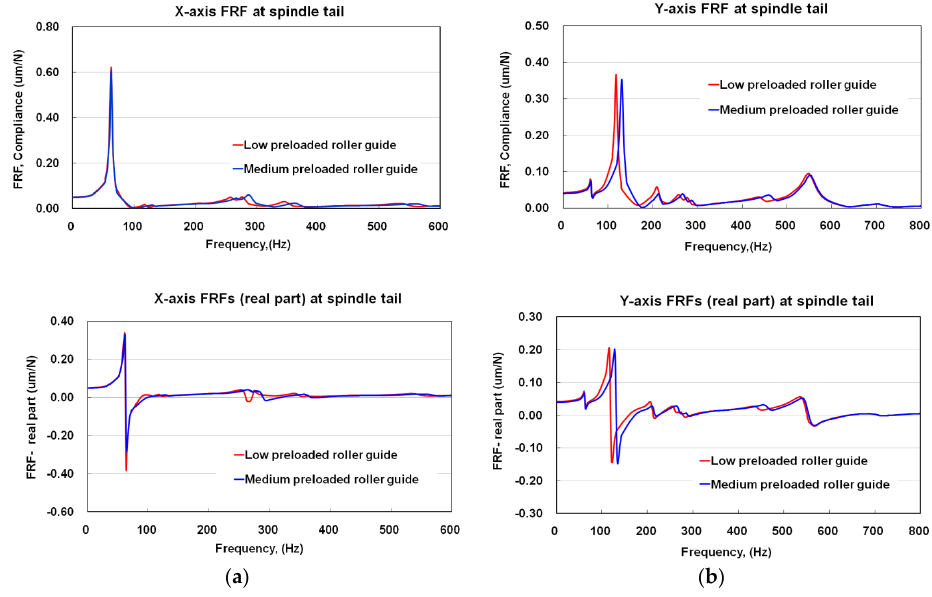
Figure 11. Comparisons of the tool end FRFs predicted for milling machine with different preloaded linear guides mounted on spindle head and movable column. ( a ) FRFs in X direction, ( b ) FRFs in Y direction.